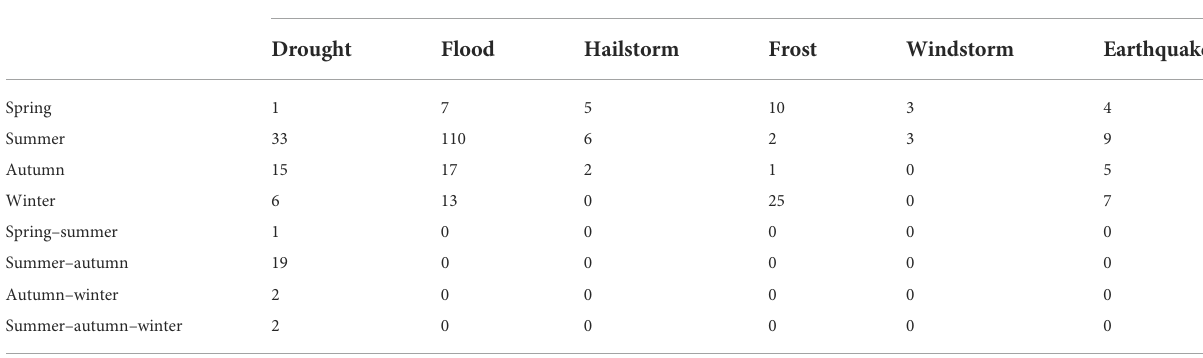
TABLE 1 Frequencies of the natural disasters in different seasons in the Huizhou region during the Ming and Qing